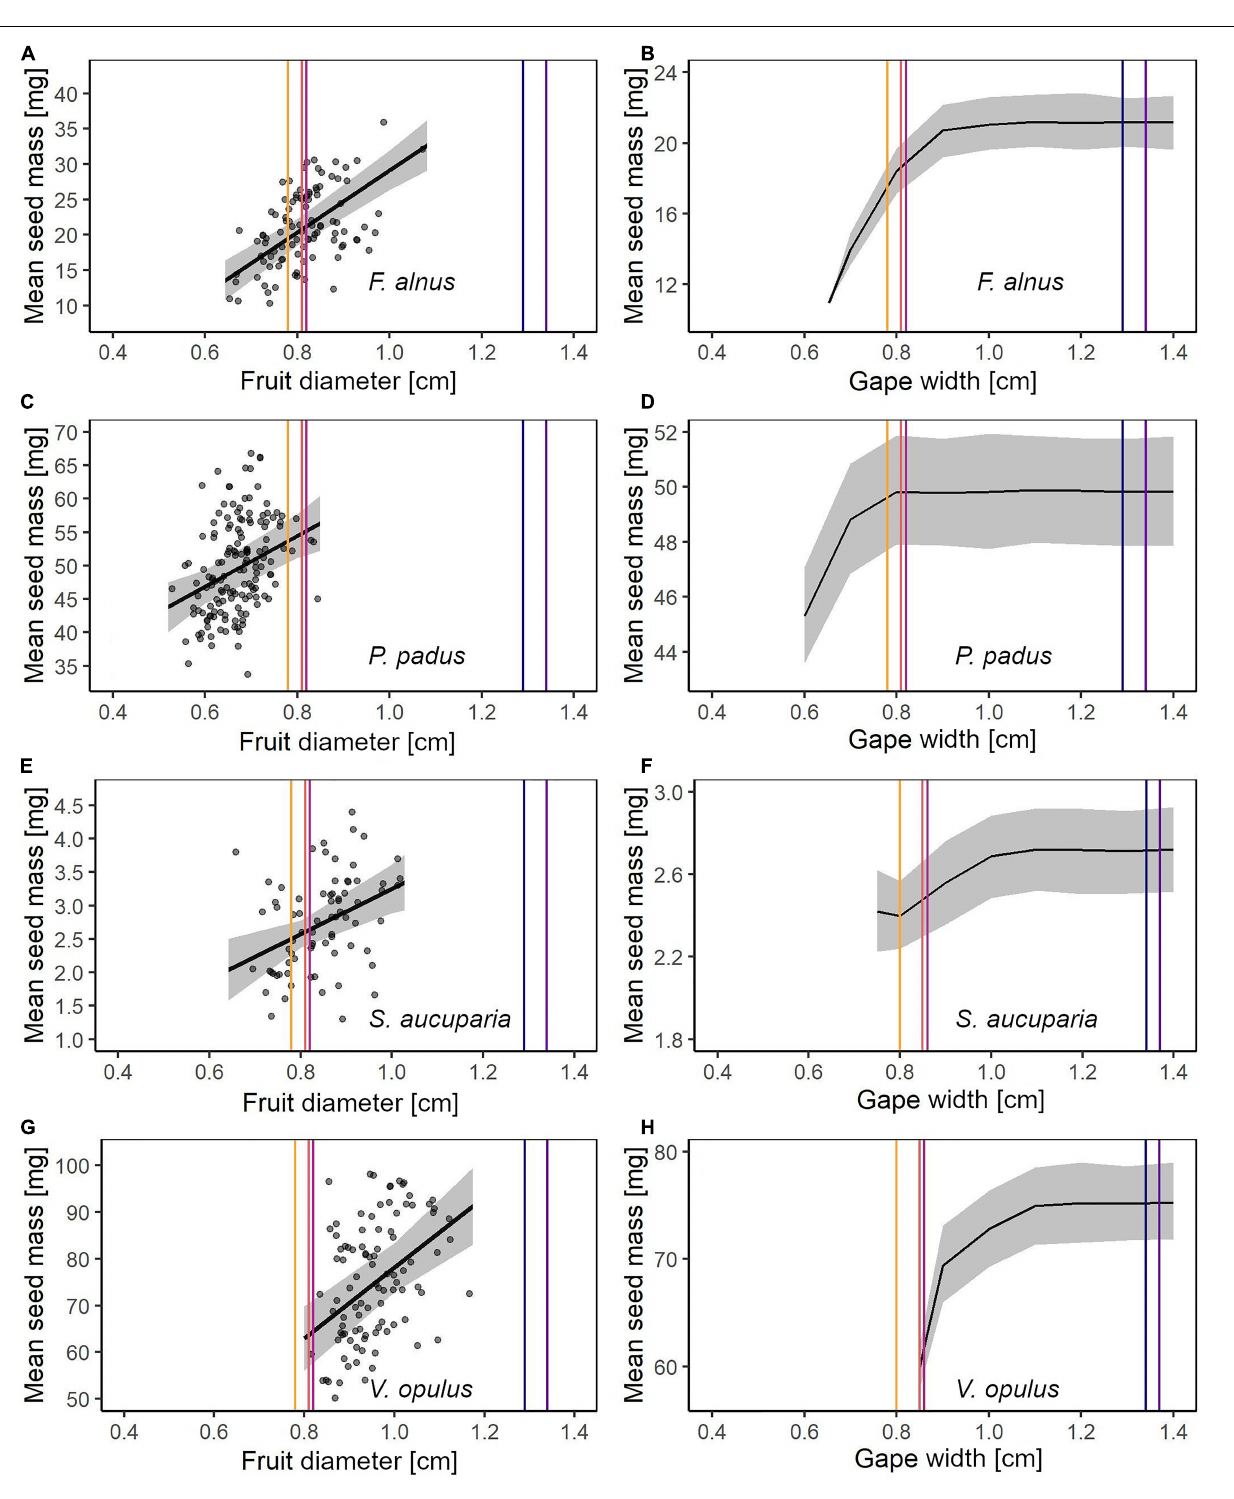
FIGURE 6 | The mean mass of seeds per fruit in relation to fruit diameter (A,C,E,G) and the mean mass of seeds per fruit taken up by animal dispersers depending on their gape width (B,D,F,H) in F. alnus (A,B) , P. padus (C,D) , S. aucuparia (E,F) and V. opulus (G,H) . In S. nigra , mean mass of seeds per fruit was related to fruit diameter, but the largest fruit was 0.617 cm and, thus, too small to induce gape-size limitations in the main disperser. Shaded areas indicate the 95% confidence intervals. The colored vertical lines display the mean gape width of the most important animal dispersers of the plant species (but M. martes with a gape width > 2 cm). Please see Figure 2 for more